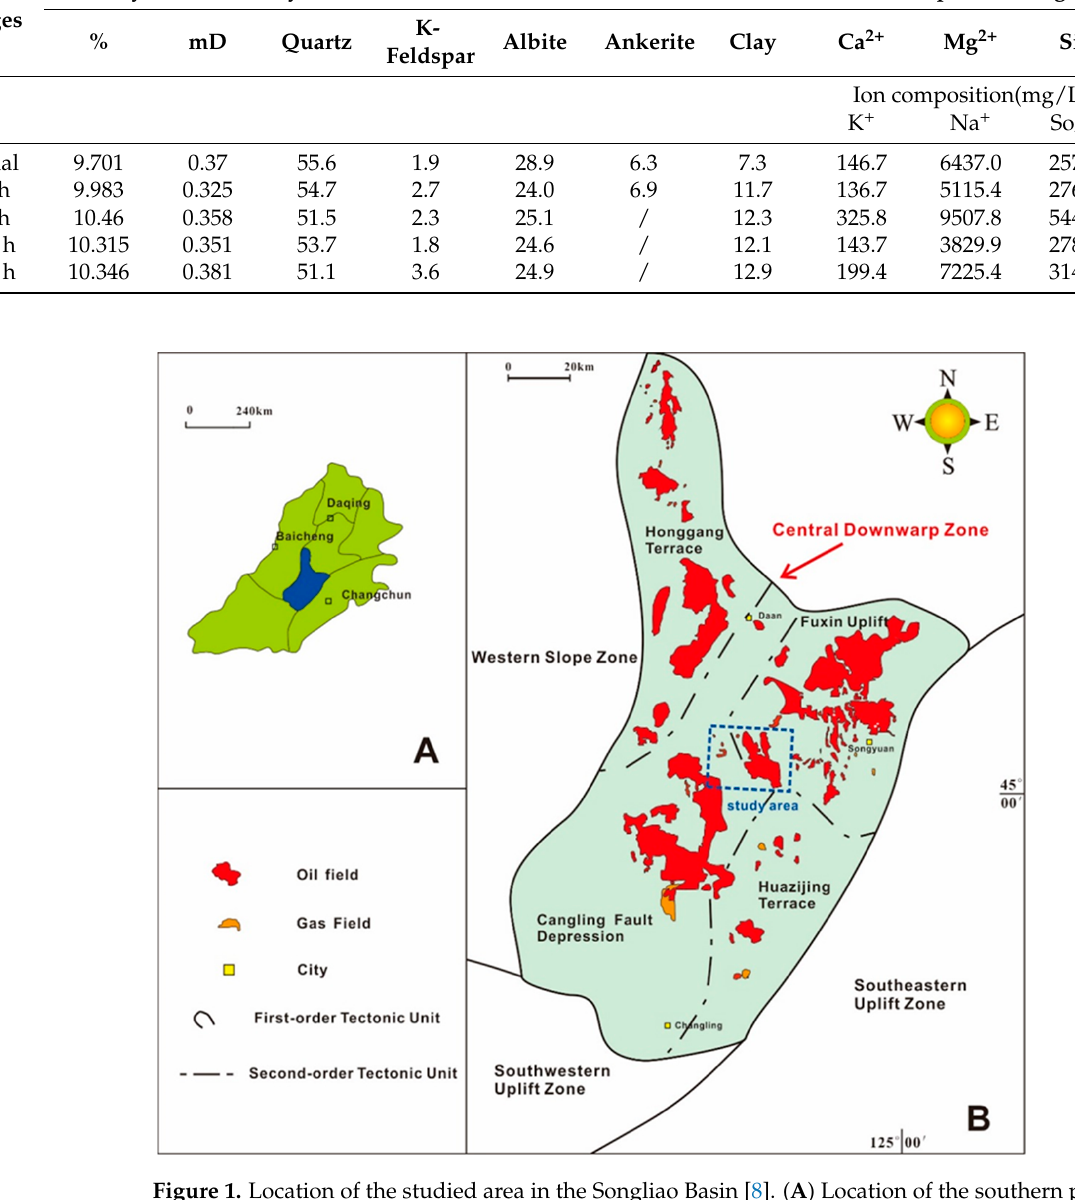
Figure 1. Location of the studied area in the Songliao Basin [8]. ( A ) Location of the southern part of the Songliao Basin (blue-filled area); ( B ) tectonic sub-division of the southern part of the Songliao Basin and the study area. Table 1. Physical properties and mineralogy and ion data of three samples at different stages.